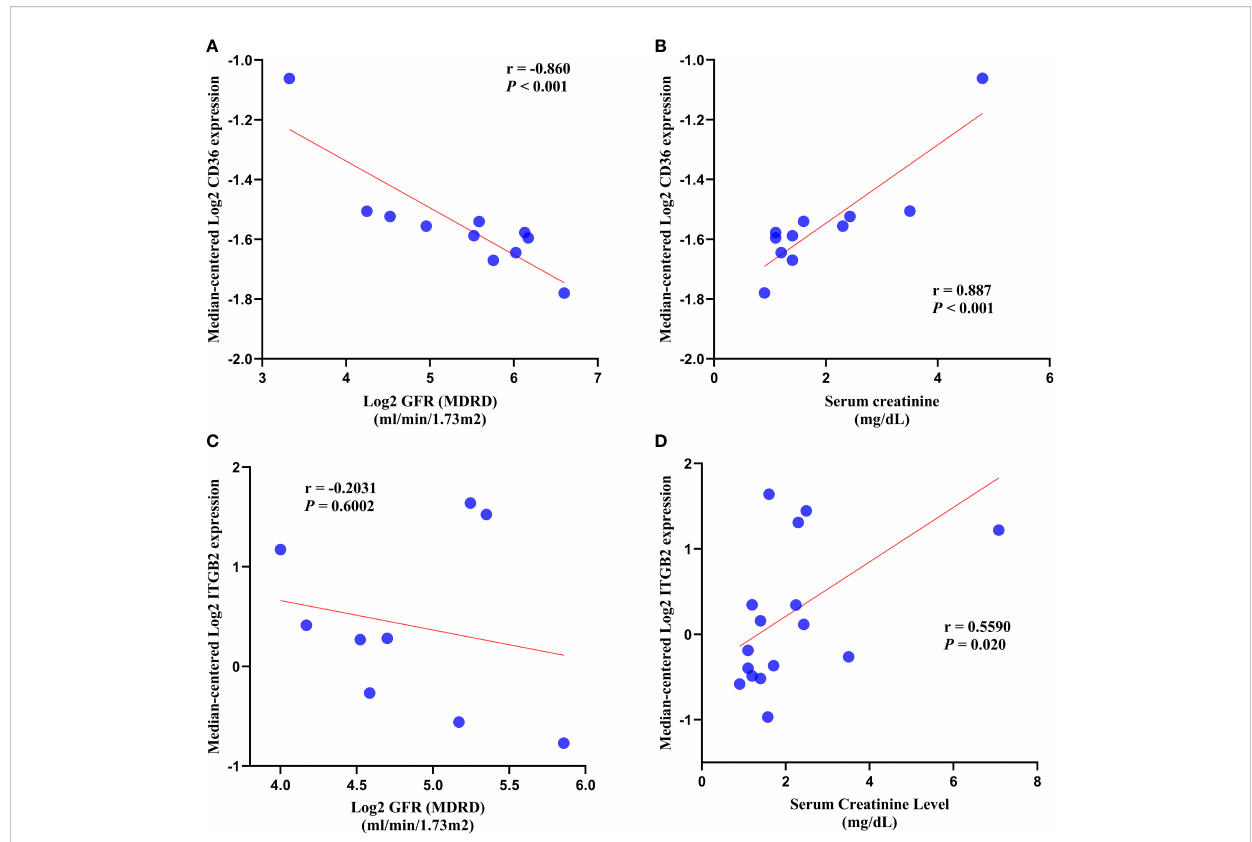
FIGURE 10 Correlation analysis . (A, B) Correlation analysis of CD36 with GFR and serum creatinine. (C, D) Correlation analysis of ITGB2 with GFR and serum creatinine. GFR, glomerular fi ltration